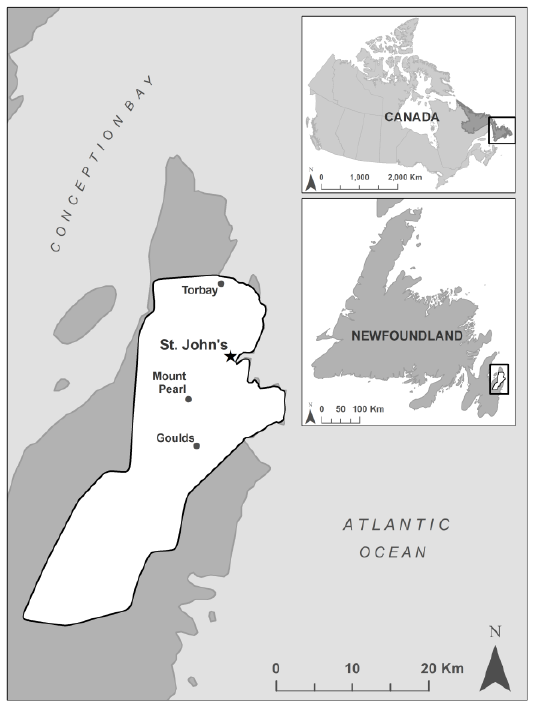
Figure 1. The location of study area.